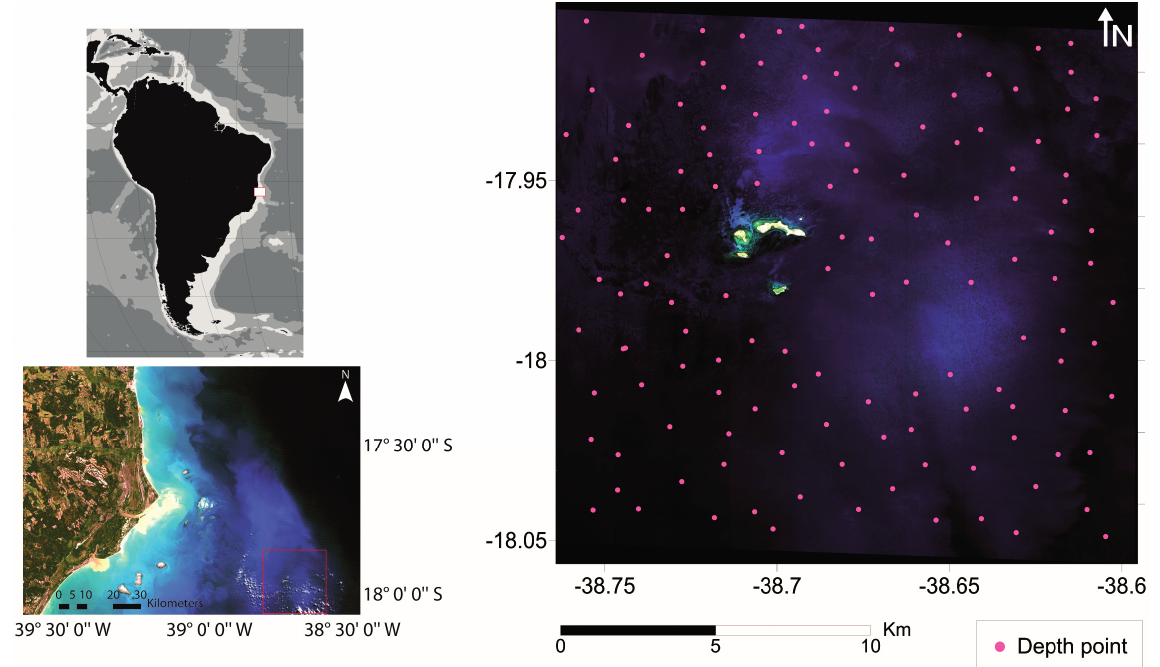
Figure 10. Quasi-true color composition (R: 659 nm; G: 546 nm; B: 478 nm) of a portion of the Abrolhos Coral Reef Bank, Brazil, around the archipelago, captured by WV02 sensor in 14 February 2012. Pink dots show distribution of depth points in the area ( Right ); Red square in image Landsat TM-5 (R: 660 nm; G: 560 nm; B: 458 nm) captured in 29 May 2006 shows location of study area respect to coast ( Lower left ); Location of study area in South America ( Upper left